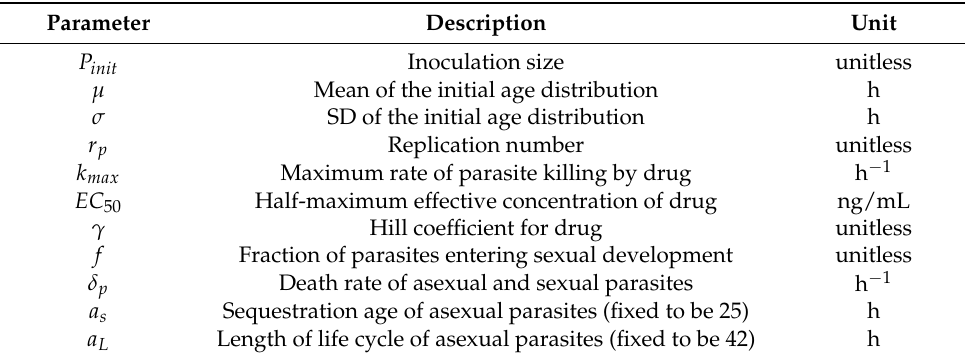
Table 1. Model parameters, unit and